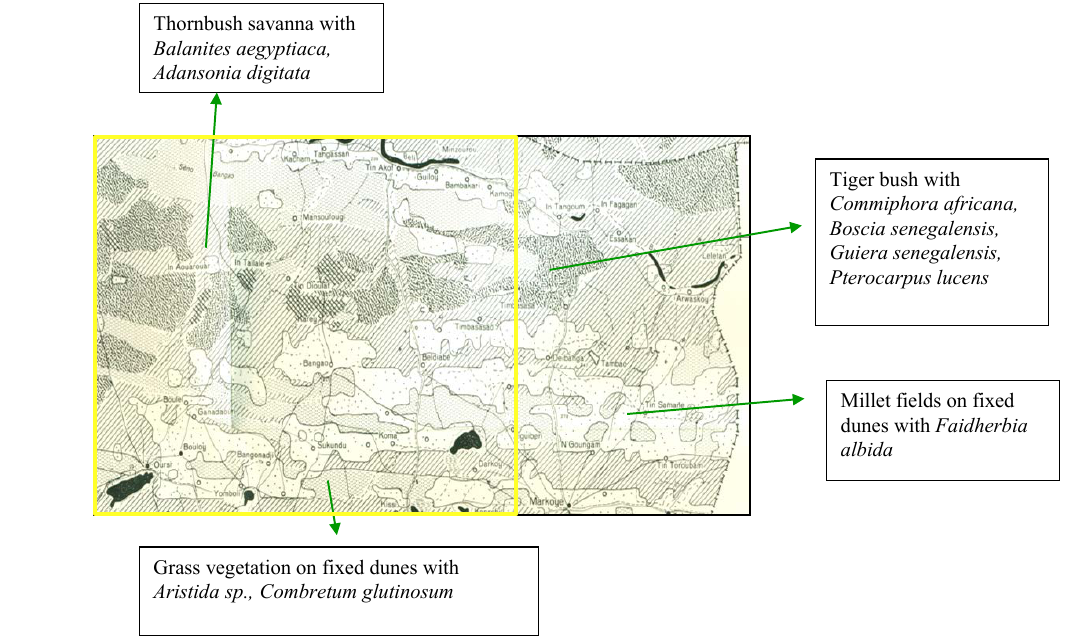
Figure 6. Vegetation and land use in the north-east of Upper Volta and lower Gourma, Mali in 1976–1977; modified after Krings (1980). The box shows the position of the satellite image section (see Fig.